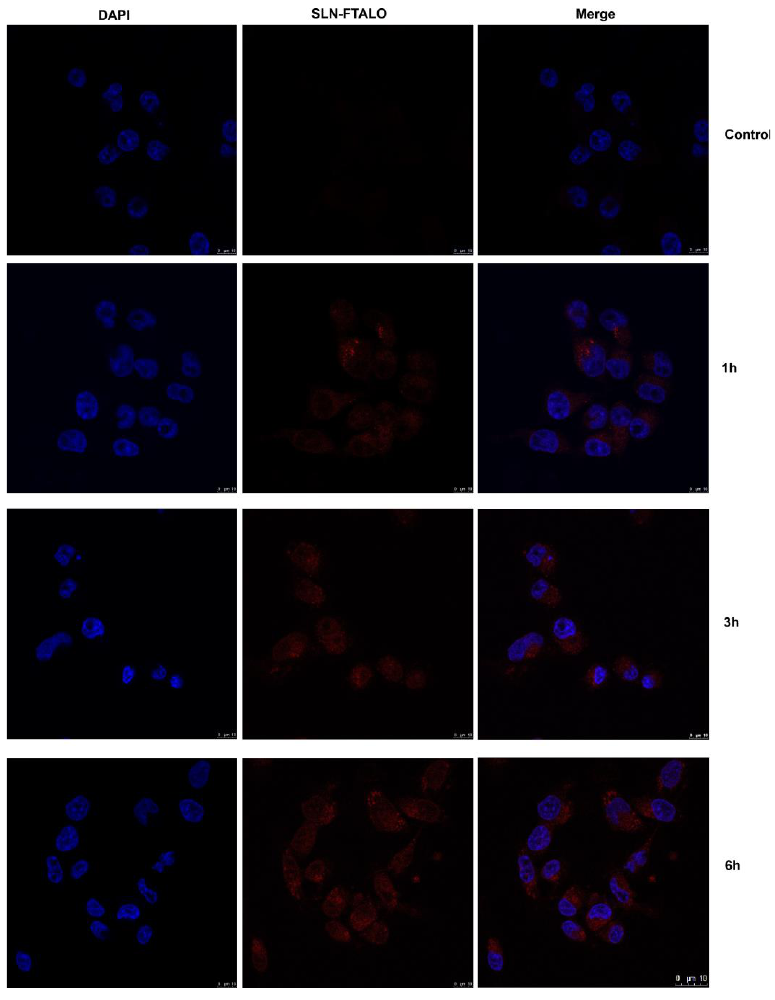
Figure 8. Confocal microscopy of MDA-MB-231 after 1 h, 3 h, and 6 h treatment with SLN- FTALO and control cells. DAPI blue stained the nucleus of the cells, while red shows the SLN- FTALO accumulated in the lysosomes region. Scale bar 10 μm.